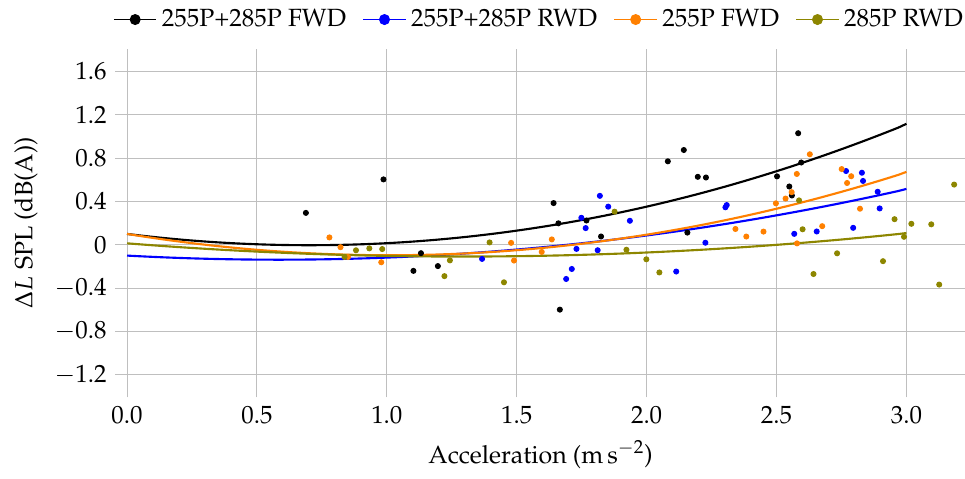
Figure 10. Air temperature corrected additional SPL caused through acceleration compared between drive axle variation for mixed and identical mounted tire combinations for left microphone side on Point